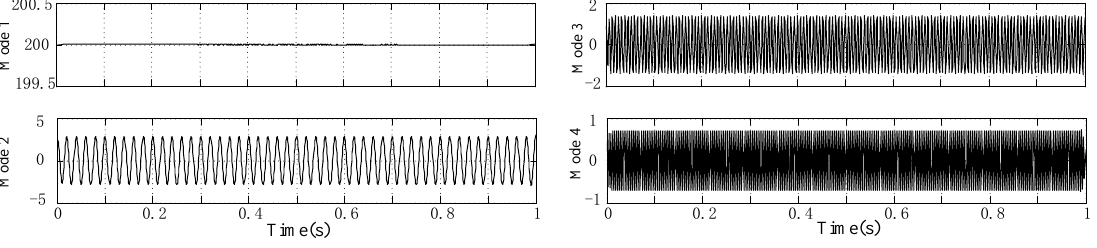
Figure 6. The decomposed modes of VMD-HT algorithms.